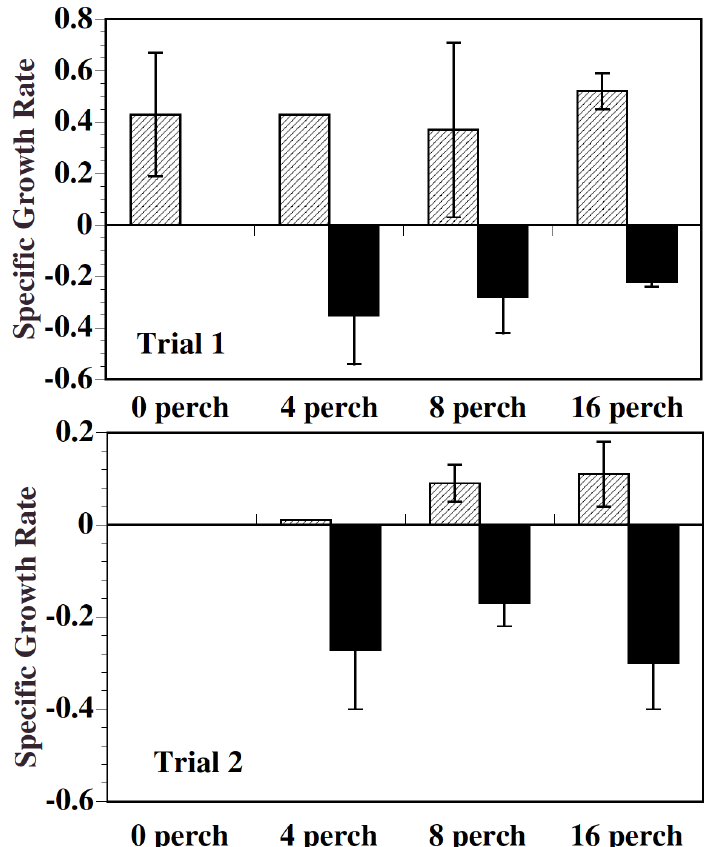
Figure 3. The effect of increasing ruffe density on specific growth rates of ruffe (striped columns) and yellow perch (solid columns) over the two five-week trials of the fish density gradient experiment (August–October 1997). Treatments consist of four replicates each of 0, 4, 8, and 16 ruffe added to 8 yellow perch. Treatment means are shown plus or minus one standard error.